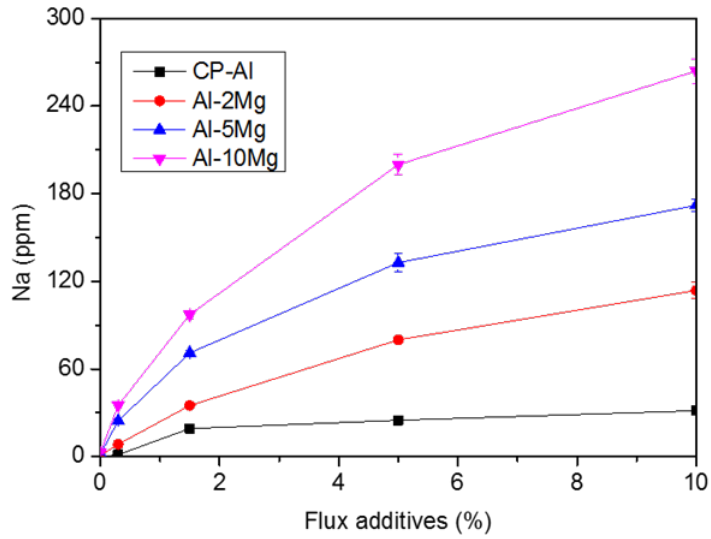
171 172 173 174 175 176 177